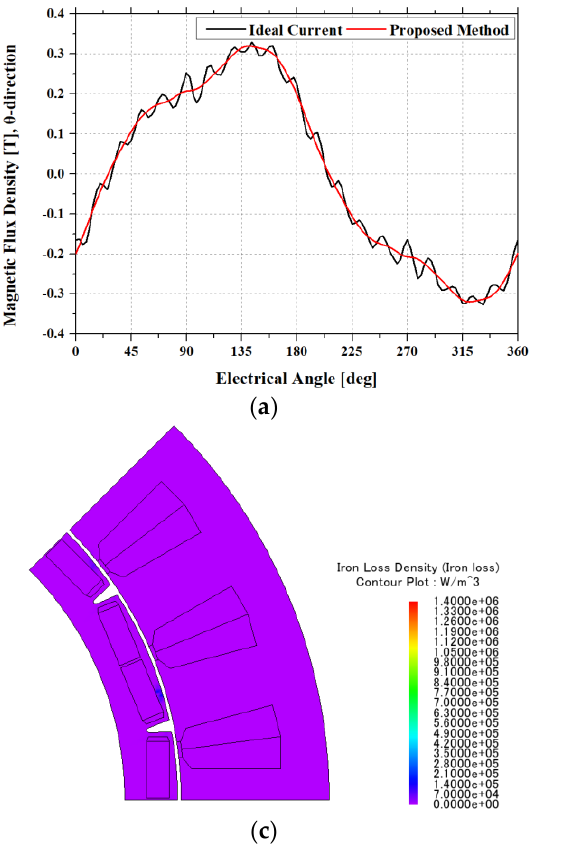
Table 2. Operating points for the experiment. Case Number